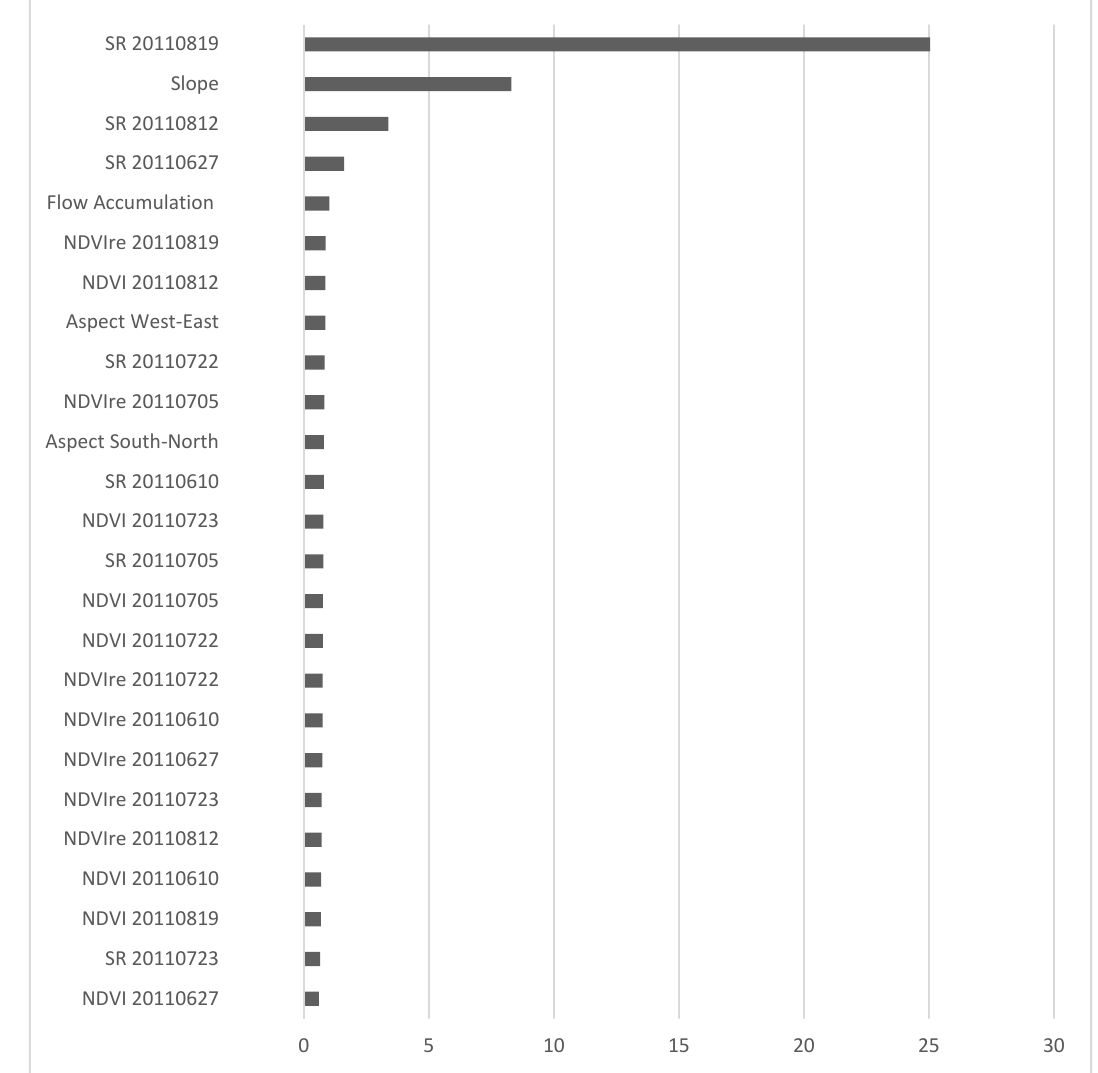
Figure A1. Importance of variables for the soybean 2011 ANN model, as measured by Garson values (larger values indicate higher importance).